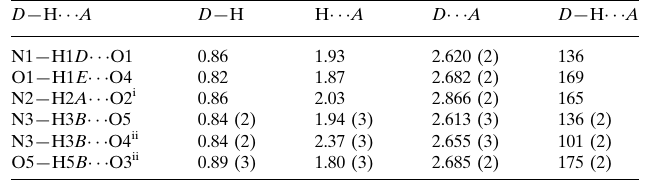
Hydrogen-bond geometry (A˚ , (cid:2)